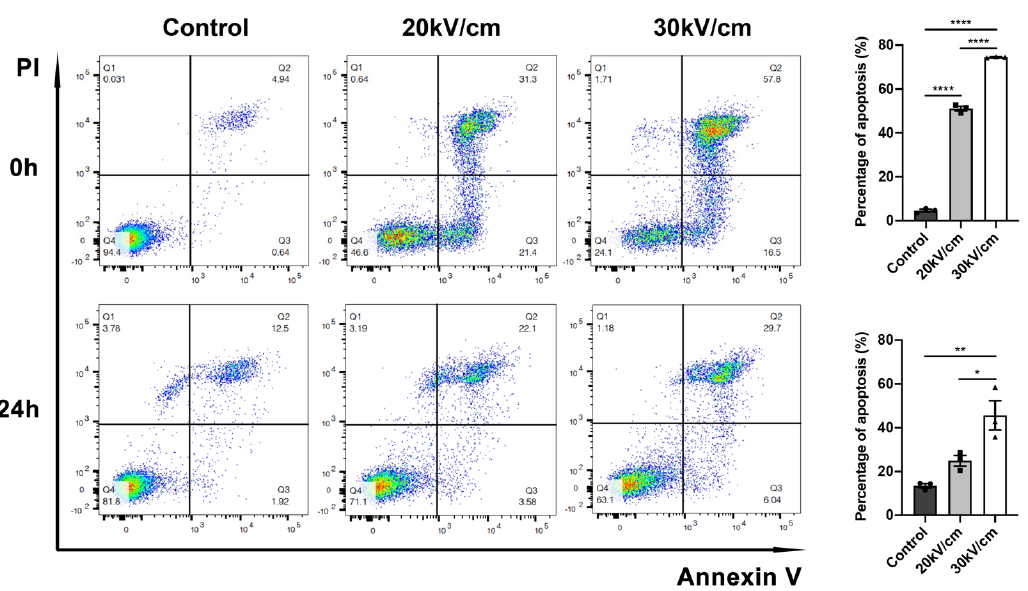
Figure 3. Fifty pulses of nsPEF were sufficient to induce a high level of apoptosis in 4T1 cells. The apoptosis of 4T1 cells in vitro was detected by flow cytometry at 0 h and 24 h. The total apoptotic rates at two timepoints are shown on the right ( n = 3). Data are presented as the mean ± SEM; * p < 0.05, ** p < 0.01, and **** p < 0.0001; ns: no significance according to one-way ANOVA.